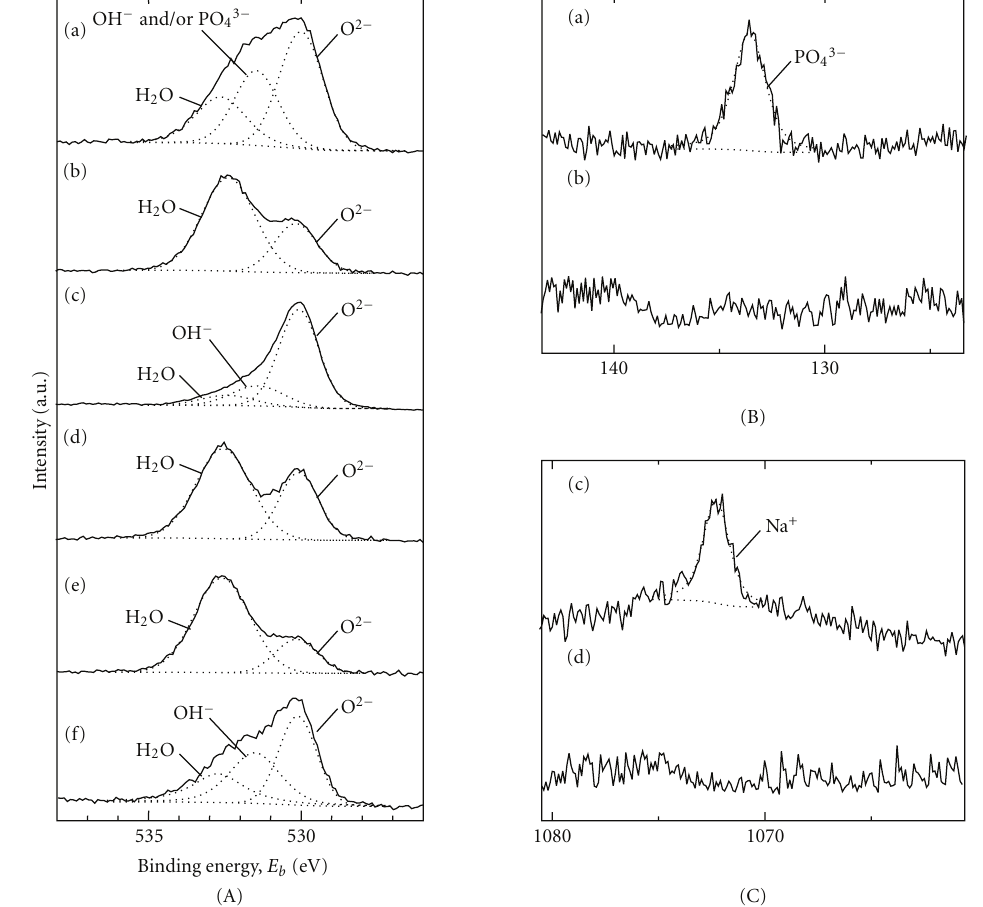
Figure 3: The (A) O1s, (B) P2p, and (C) Na1s XPS surface spectra of samples treated by (a) AZ treatment up 100 V in 0.1 M H 3 PO 4 aq., (b) AZ-TO treatment (anodized in H 3 PO 4 aq.), (c) AZ treatment up to 80 V in 0.1 M NaOH aq., (d) AZ-TO treatment (anodized in NaOH aq.), and (e) TO